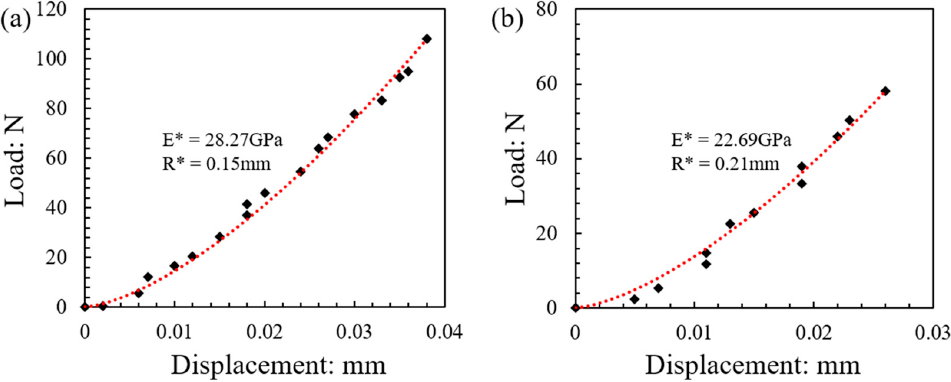
Figure 9. ( a,b ) Two examples of Hertz fitting to the load–displacement curves to estimate contact Young’s modulus (corresponding to 0.01 mm/min speed).